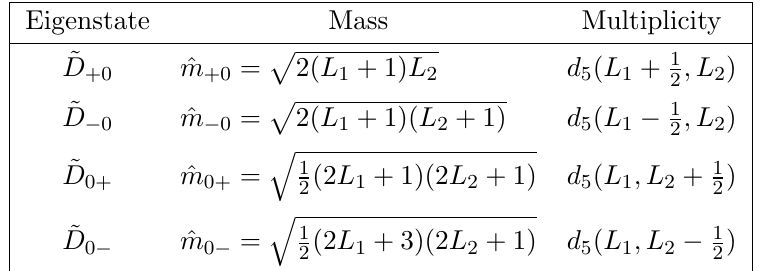
Table 5 . Mass eigenvalues of the fermions in the adjoint block. The allowed ranges of L 1 and L 2 are 0 (cid:20) L 2 (cid:20) L 1 , L 1 + L 2 (cid:20) n . Note that in the case L 2 = L 1 the (cid:12)elds ~ D (cid:0) 0 and ~ D 0+ are missing, and in the case L 2 = 0 the ~ D 0 (cid:0) (cid:12)elds are missing. The de(cid:12)nition of d 5 can be found in (A.8). Eigenstate Mass